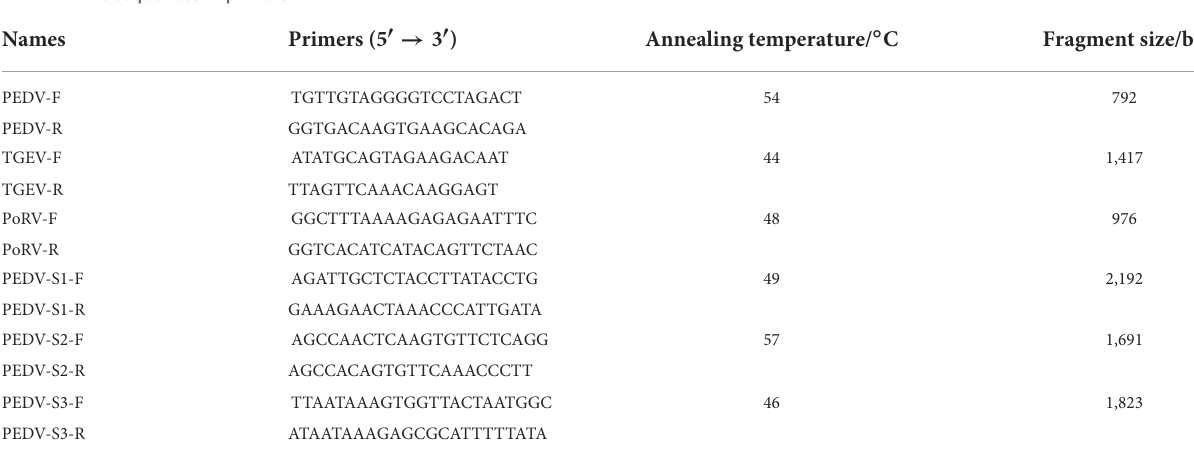
TABLE 1 The sequences of